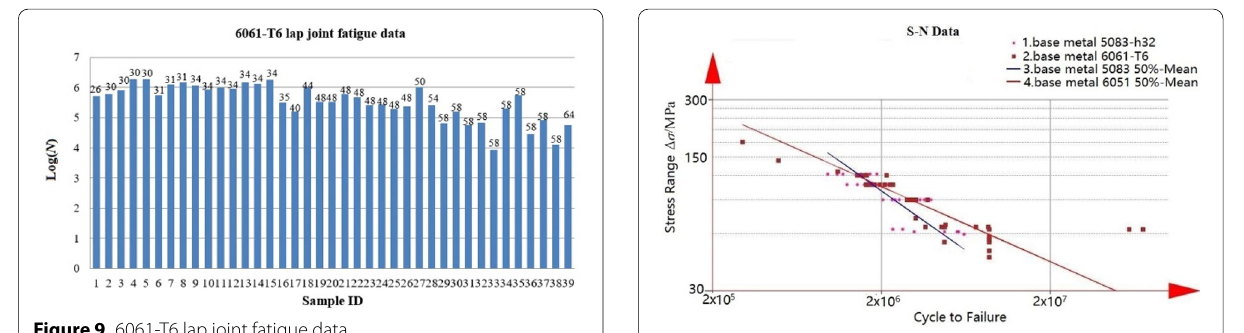
Figure 12 Fatigue test data of base metal (70 specimens in total)